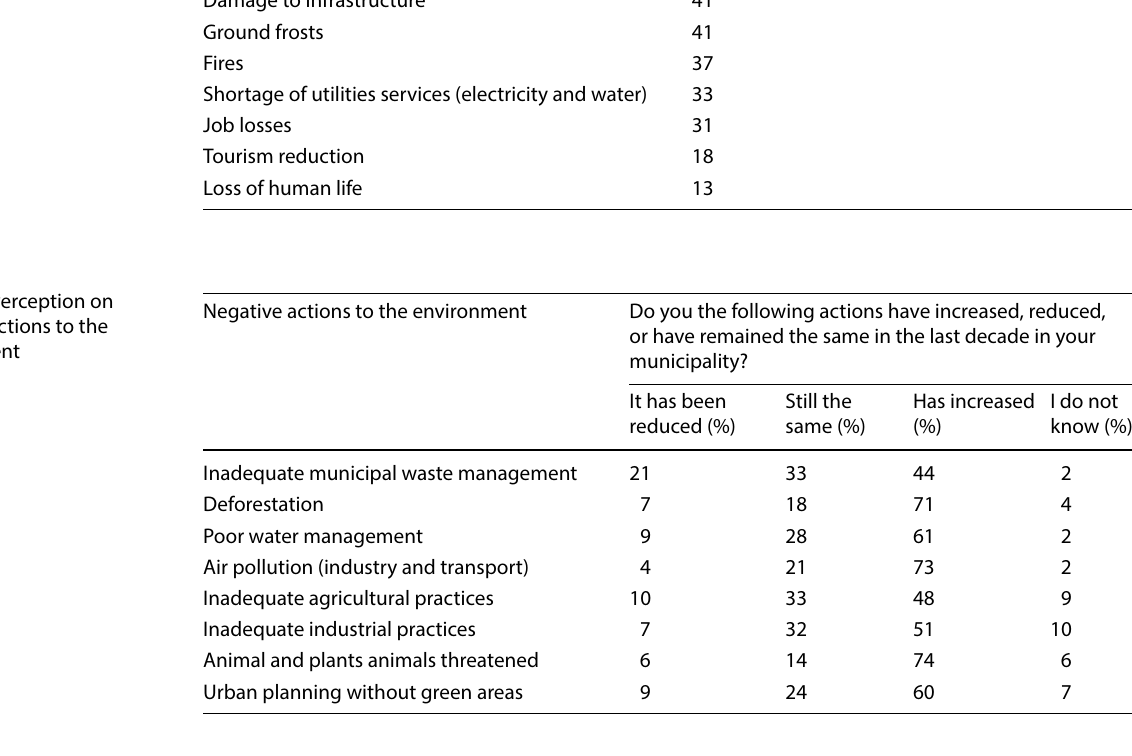
Table 11 Percentage of people who think the problem may get worse in the future because of climate change in their